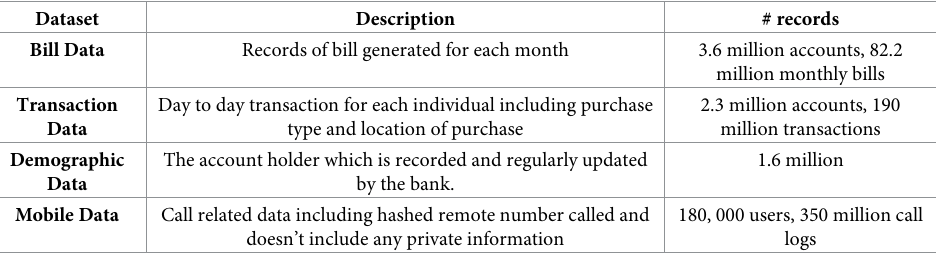
Table 1. Dataset summary for various data sources used in the